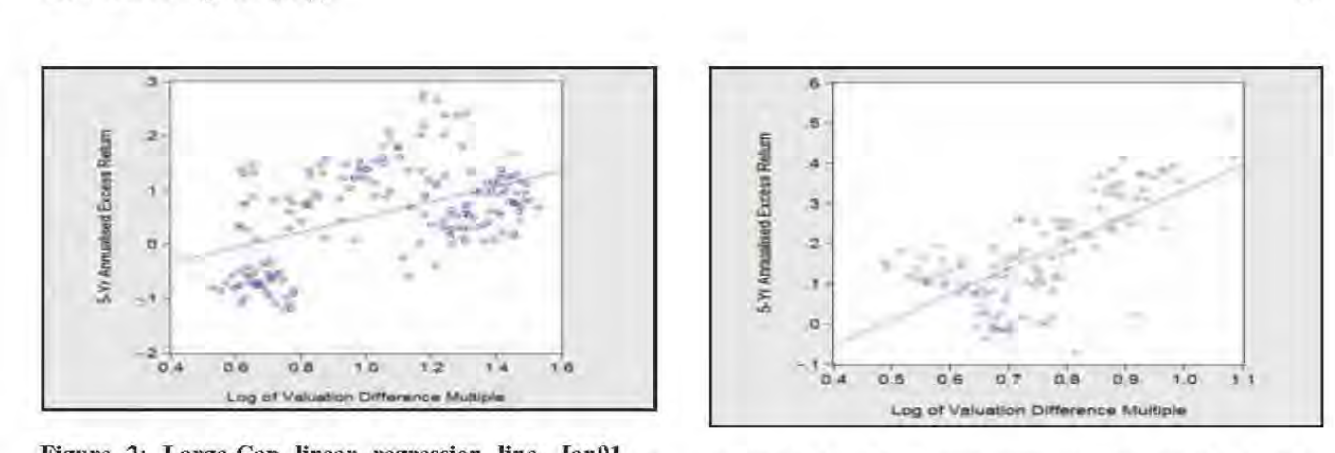
Figure 3 indicates a robust positive relationship between the ftve-year annualized excess return and the log of the valuation difference multiple, which is confrrmed by a correlation coefftcient of0,68. Table 2: Mid-Cap OLS estimation output, Aug97 -